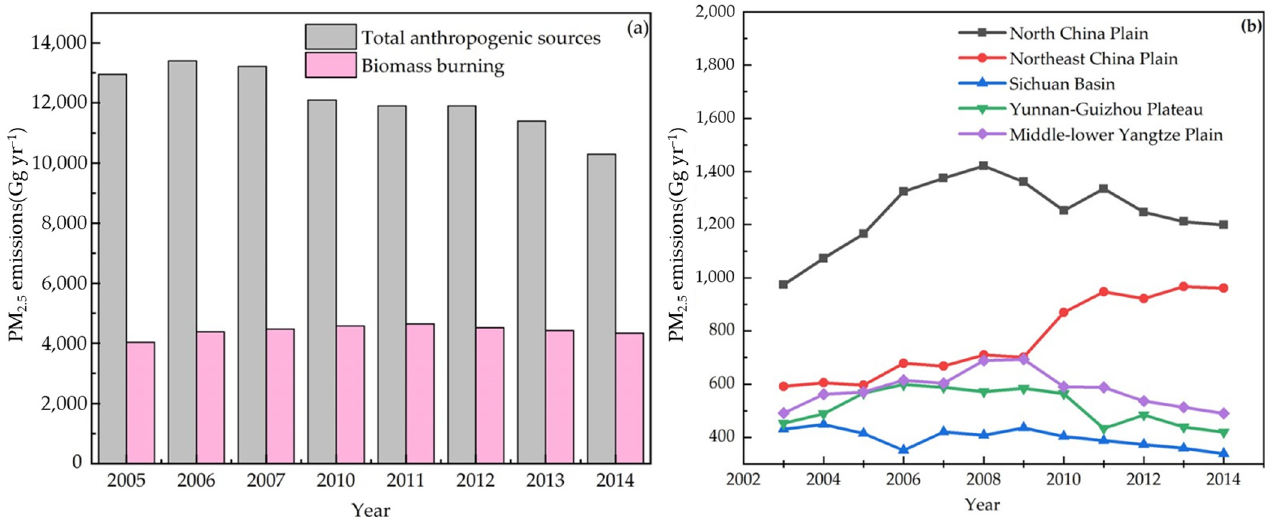
Figure 4. ( a ) Annual PM 2.5 emissions from total anthropogenic sources and biomass burning in some years in China and ( b ) annual PM 2.5 emissions from biomass burning in different regions of China [41].